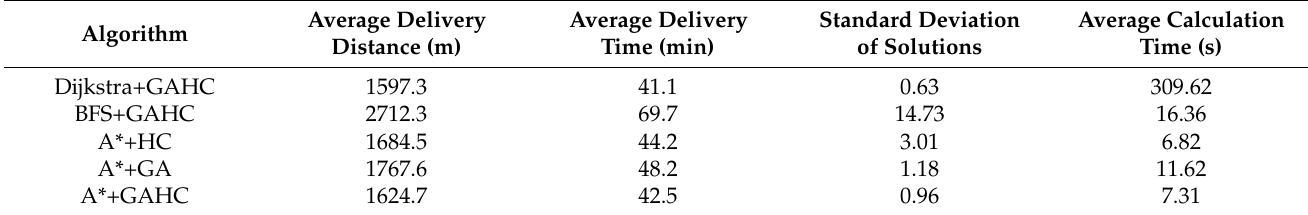
Table 6. Comparison of results after calculated in various